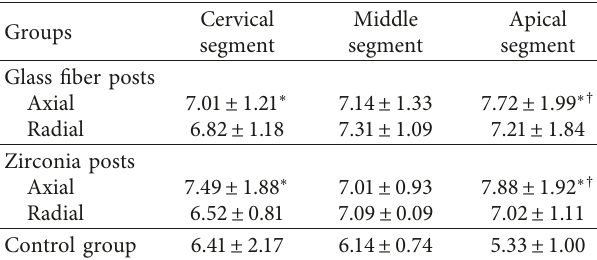
Table 3: Push-out bond strength values of the cervical, middle, and apical segments (MPa) ( ± SD).